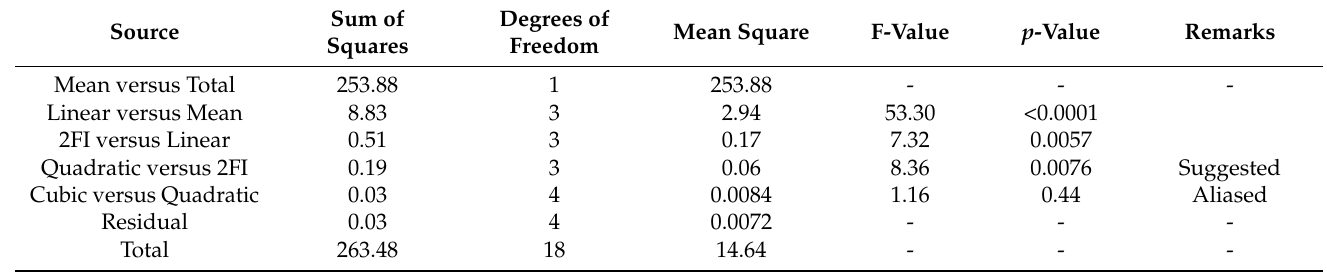
Table 2. Model sum of squares for SCCO 2 extraction of cannabis leaves.